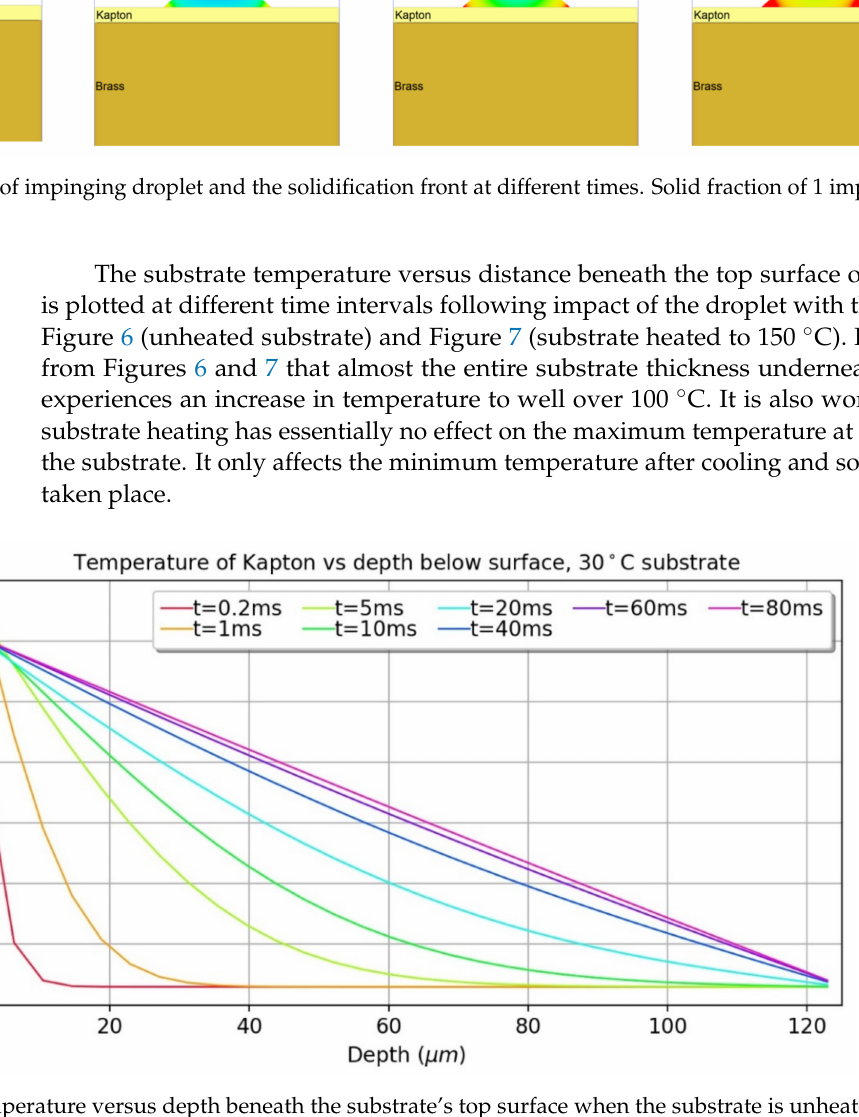
Figure 6. Substrate temperature versus depth beneath the substrate’s top surface when the substrate is unheated (30 ◦